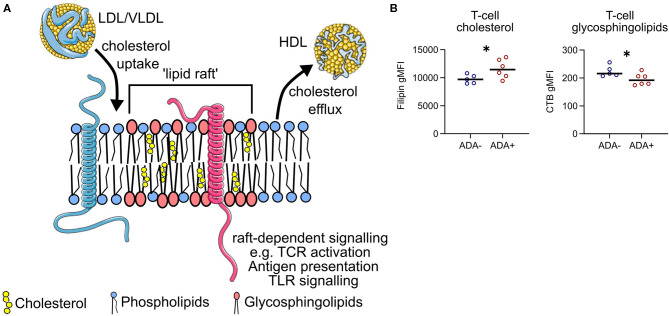
Lipid raft-associated proteins are differentially expressed between ADA– and ADA+. (A) Lipoproteins can add or remove cholesterol from the plasma membrane of immune cells. This can alter the composition of “lipid rafts”—membrane microdomains enriched for glycosphingolipids and cholesterol. The tight packing of these lipids generates a region of relative “order” which can selectively attract membrane signaling proteins (e.g., pink protein), whilst excluding others (e.g., blue protein). Examples of raft-dependent signaling include T cell antigen receptor (TCR) signaling, antigen presentation and pro-inflammatory toll-like receptor (TLR) signaling. (B) Cholesterol and glycosphingolipid levels were measured in CD4+ T cells from ADA– (n = 5) or ADA+ (n = 6) multiple sclerosis patients at M0, in five independent experiments. Binding of filipin to cholesterol and cholera-toxin B (CTB) to glycosphingolipids was assessed by flow cytometry. Un-paired two-tailed t-test; *p < 0.05.